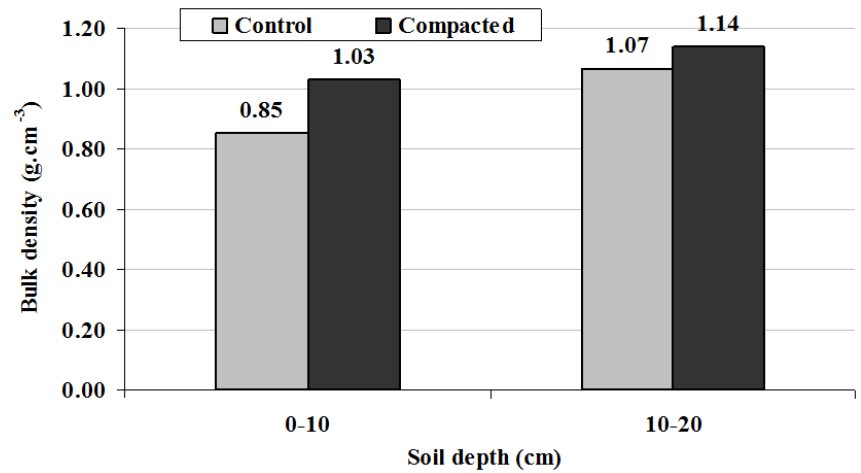
Fig. 2. Comparison of bulk density in both control and compacted tail in the soil depth